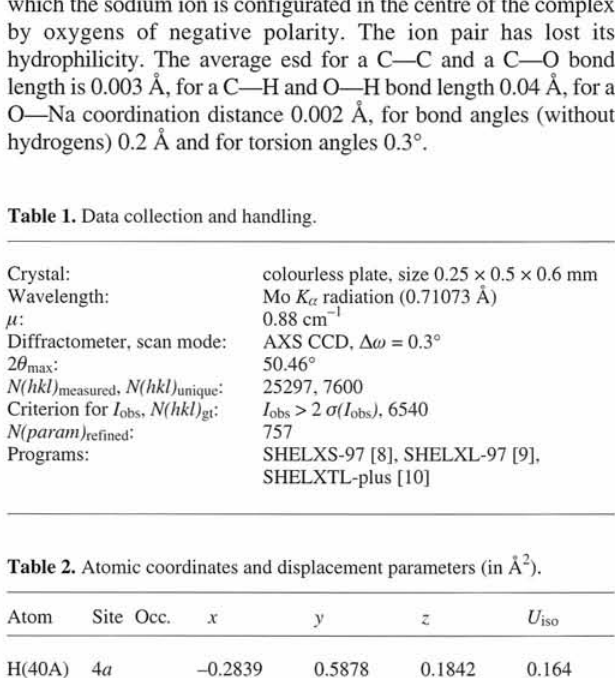
Table 2. Atomic coordinates and displacement parameters (in Â 2 ).